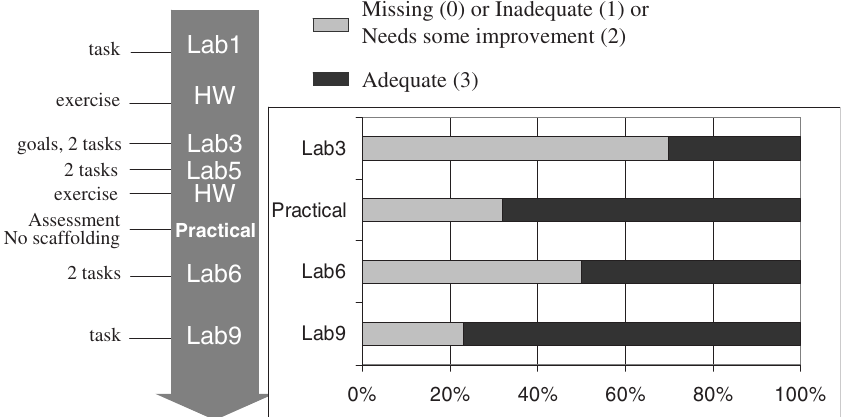
FIG. 7. Ability to distinguish between hypotheses and predic- tions. The dark shaded bar repre- sents the percentage of the stu- dents whose laboratory reports received the score of 3 (cid:1) adequate (cid:2)